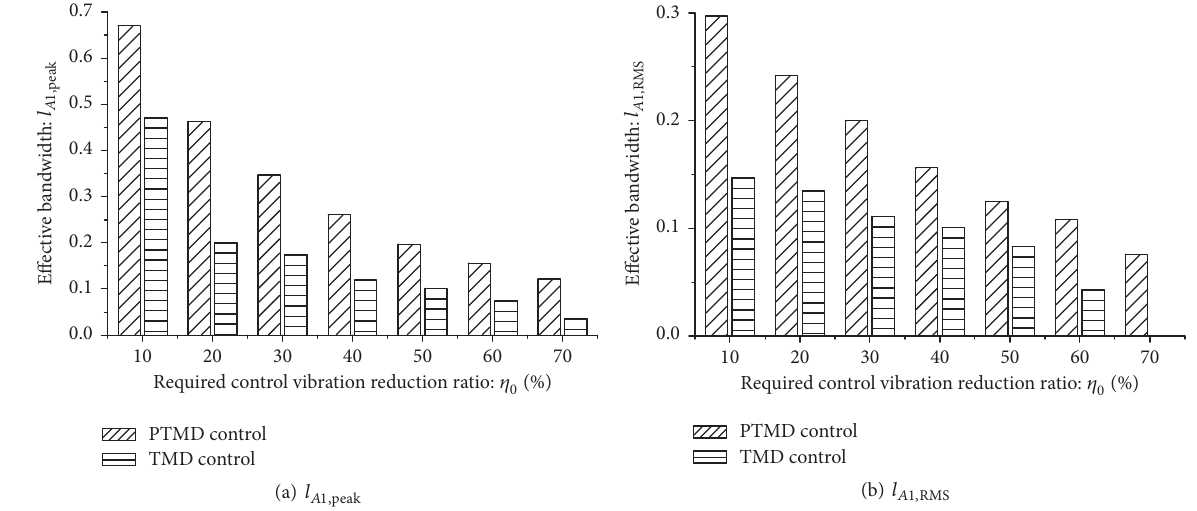
Figure 13: Comparison of effective bandwidth on dimensionless